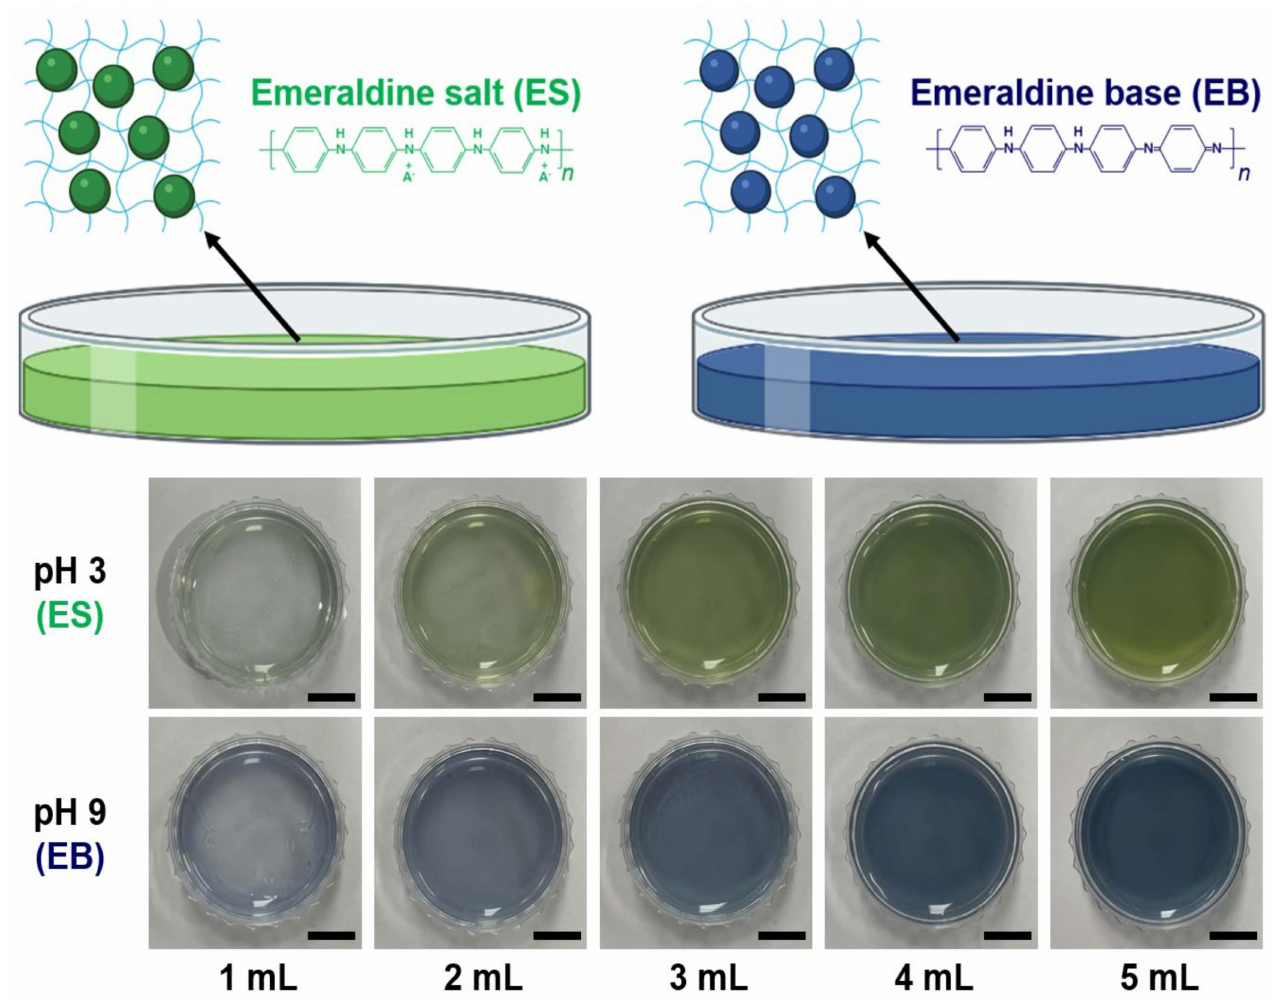
Figure 3. Molecular structure inside the PNHC with pH, and the effect of volume on the colorimetric properties of PNHC. Schematic illustration of the molecular structure inside the PNHC fabricated at different pH (3 and 9). Images of PNHCs with different volumes (1, 2, 3, 4 and 5 mL) at pH 3 and 9. Scale bar represents 1